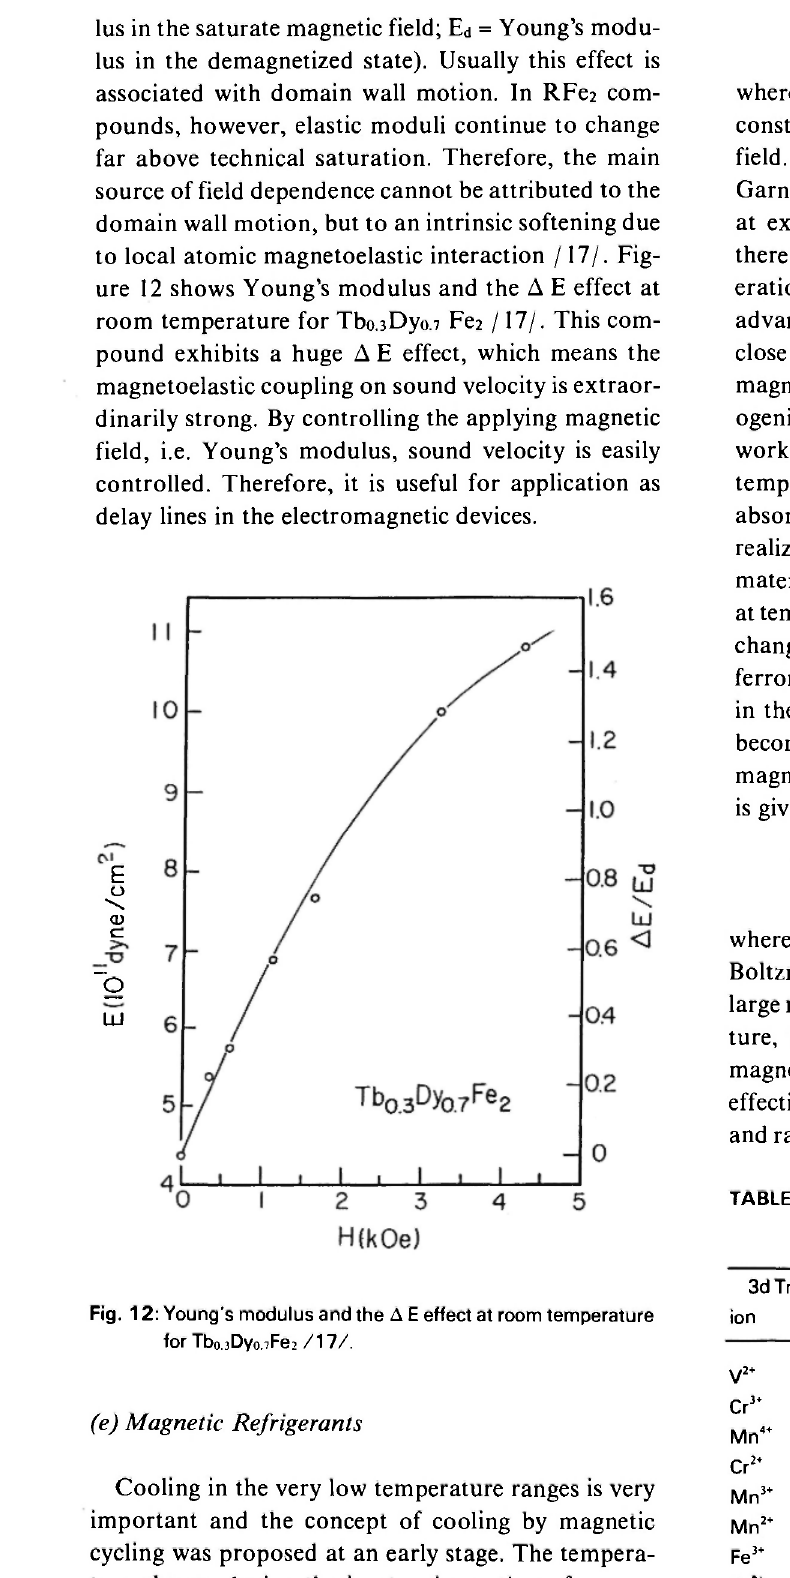
Fig. 12: Young's modulus and the Δ Ε effect at room temperature for Tbo .3Dyo .7Fe2 /17/.